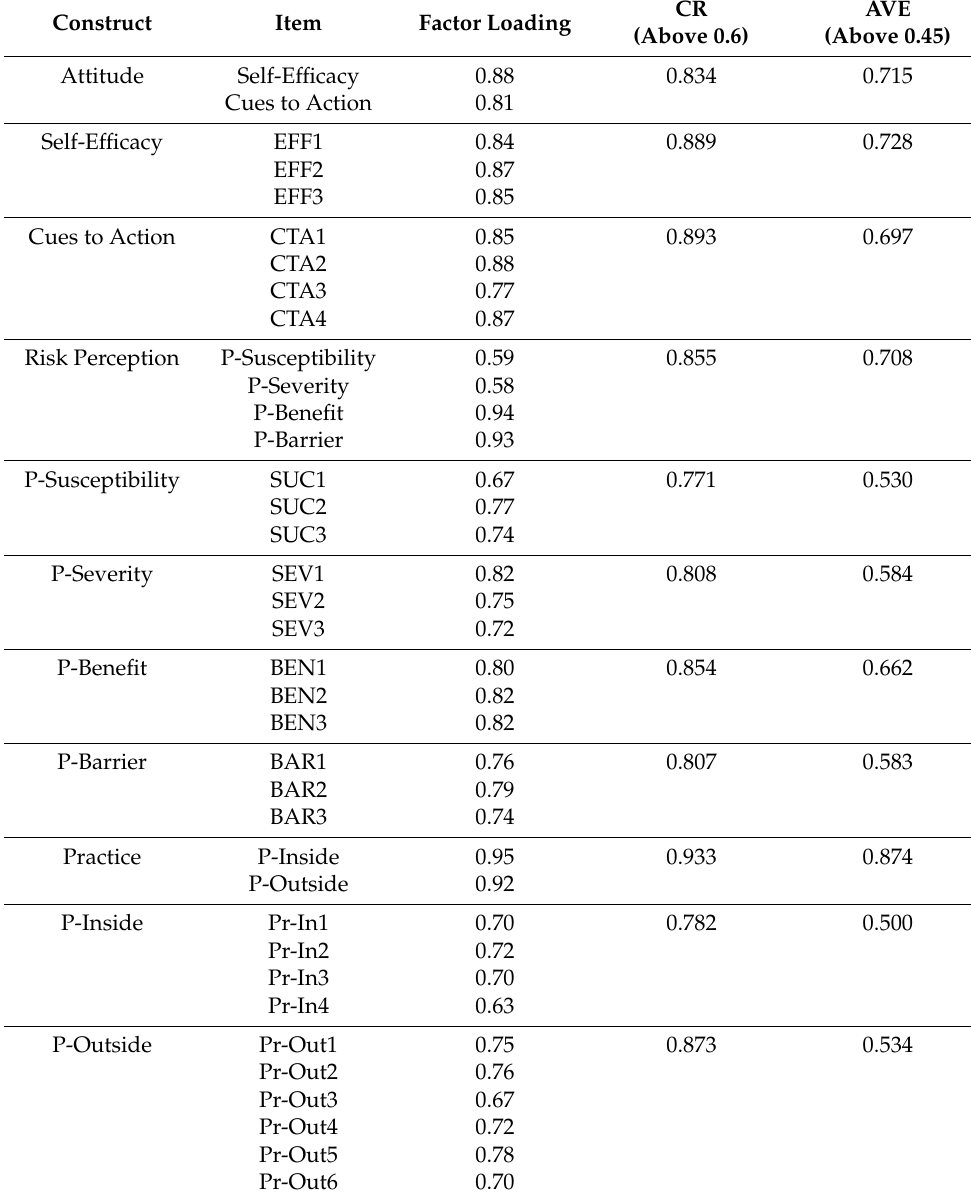
Table 4. The Average Variance Extracted (AVE) and Composite Reliability (CR).